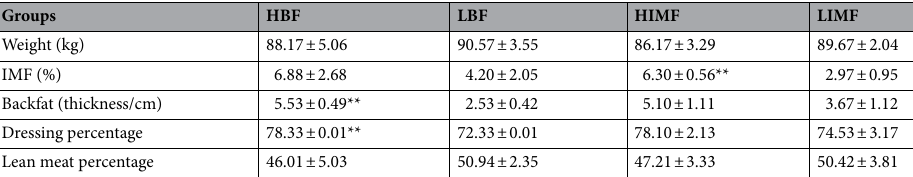
Table 1. Phenotypic data at slaughter and meat quality of Dingyuan pigs. The results are expressed as mean ± SD. IMF Intramuscular fat, LBF low backfat thickness, HBF high backfat thickness, HIMF high intramuscular fat, LIMF low intramuscular fat. **indicates extremely significant ( P < 0.01). No label indicates that the difference is not